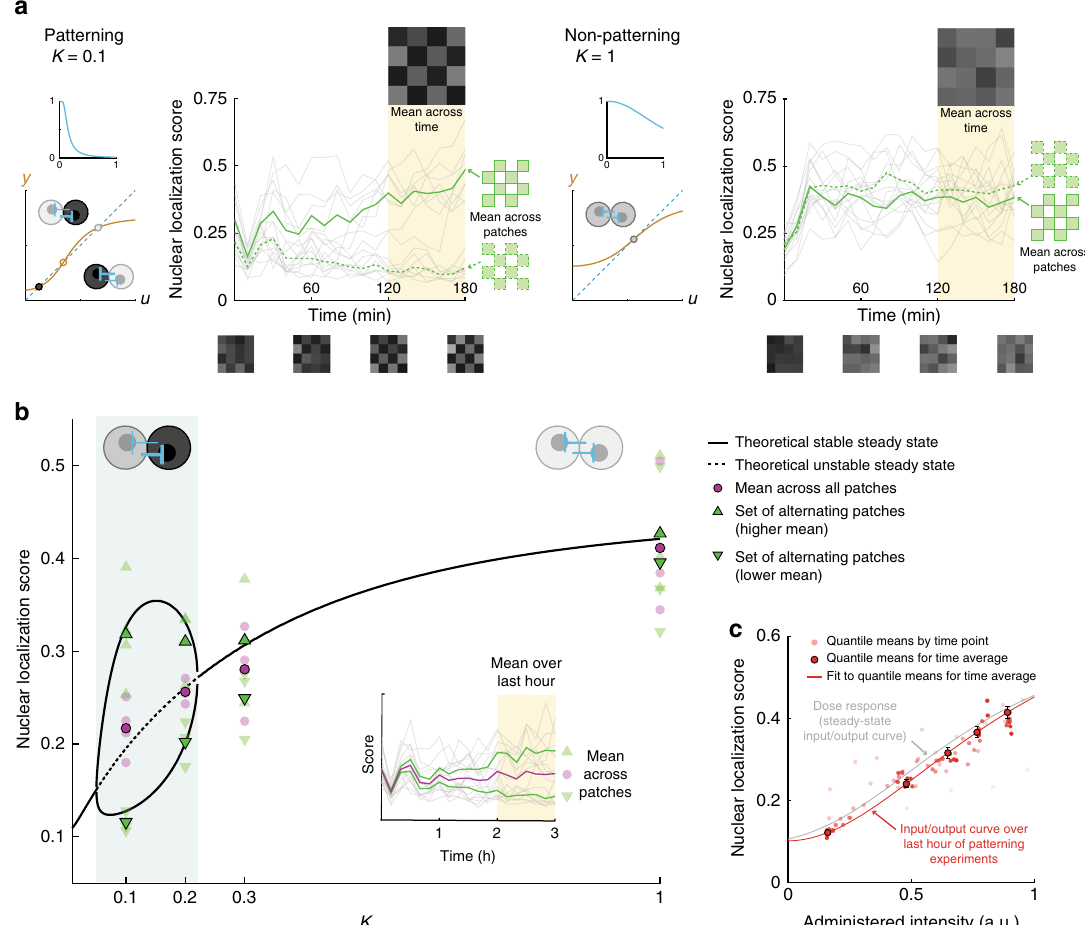
Fig. 5 Theory quantitatively predicts spontaneous patterning and patch intensity during cell-in-the-loop experiments. a Sample time traces show emergence of a contrasting pattern ( K = 0.1) or convergence to a non-patterning state ( K = 1). Gray lines correspond to score traces for individual patches; green lines indicate the mean scores of sets of alternating patches. Checkerboards visualize scores at single time points (bottom) or averaged over the last hour (top). b Theory quantitatively recapitulates experimental results for mean patch response score. Black lines denote theoretical steady-state points as a function of the bifurcation parameter K , with solid indicating stable and dashed, unstable. All points are averaged over the last hour. Faded points correspond to individual experiments; solid outlines are averages across experiments ( N = 4 for K = 0.1, N = 3 for K = 0.2, 0.3, 1). Magenta circular points are averages over all patches. Green points are averages over sets of alternating patches, with upward- and downward-facing triangles denoting the higher and lower of the two means respectively. Stochasticity in the experimental system introduced contrast between the average means of sets even in regions that were deterministically suggested to be monostable. As predicted, the contrast level (difference between means of sets of alternating patches) was higher for lower K . Experiment-to-experiment variation in overall brightness (score averaged across all patches) was greater for higher K , an effect that cannot be accounted for in a purely deterministic theory. c The 16-patch system with six cells per patch converges to a steady state by ~2 h into patterning experiments. Solid outline, score values averaged over the last hour for individual patches and split into quantiles by administered intensities show decent agreement with the empirical steady-state dose response curve. Error bars are s.e.m. Circles without outlines are quantiles at individual time points pooled from N = 13 experiments (darker red at later times). For comparison, the dose response curve fi t to empirical data is plotted in gray. Source data are provided as a Source Data fi